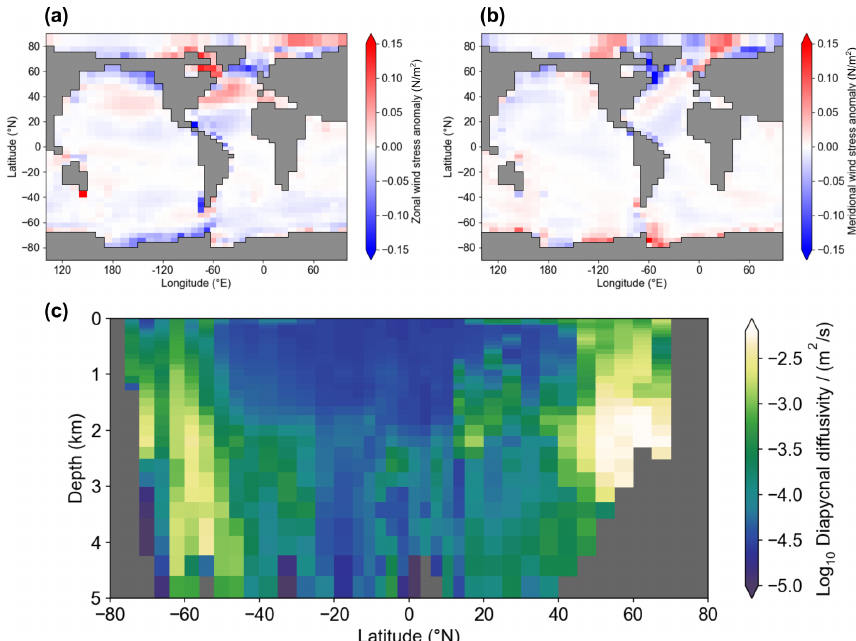
Figure B2. Additional changes in LGM boundary conditions. (a, b) Multi-model mean wind stress anomalies of five PMIP3 models (CCSM4, CNRM, GISS, MIROC, and MPI) following Muglia and Schmittner (2015). The large positive anomaly south of Australia is a regridding artifact due to the lack of Tasmania in the Bern3D model. (c) Zonally averaged diapycnal diffusivities of the Atlantic, which are regridded on the Bern3D grid from the UVic climate model coupled to the OTIS tide model with sea level derived from ICE-6G (Wilmes et al., 2019).